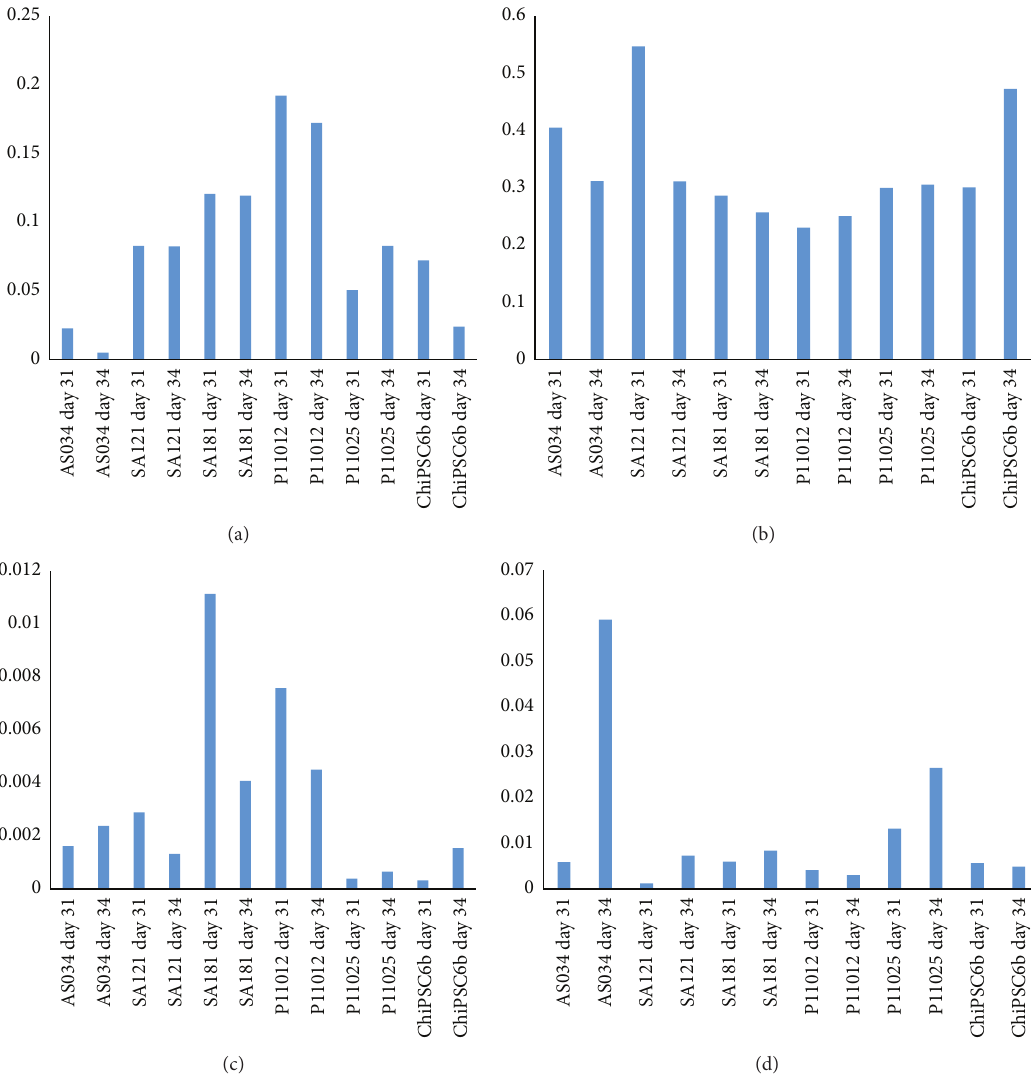
protein and incubation time. Figure 18 shows interindividual variation in the different CYP enzyme activities in the hepatocyte-like cells generated from the different hPSC